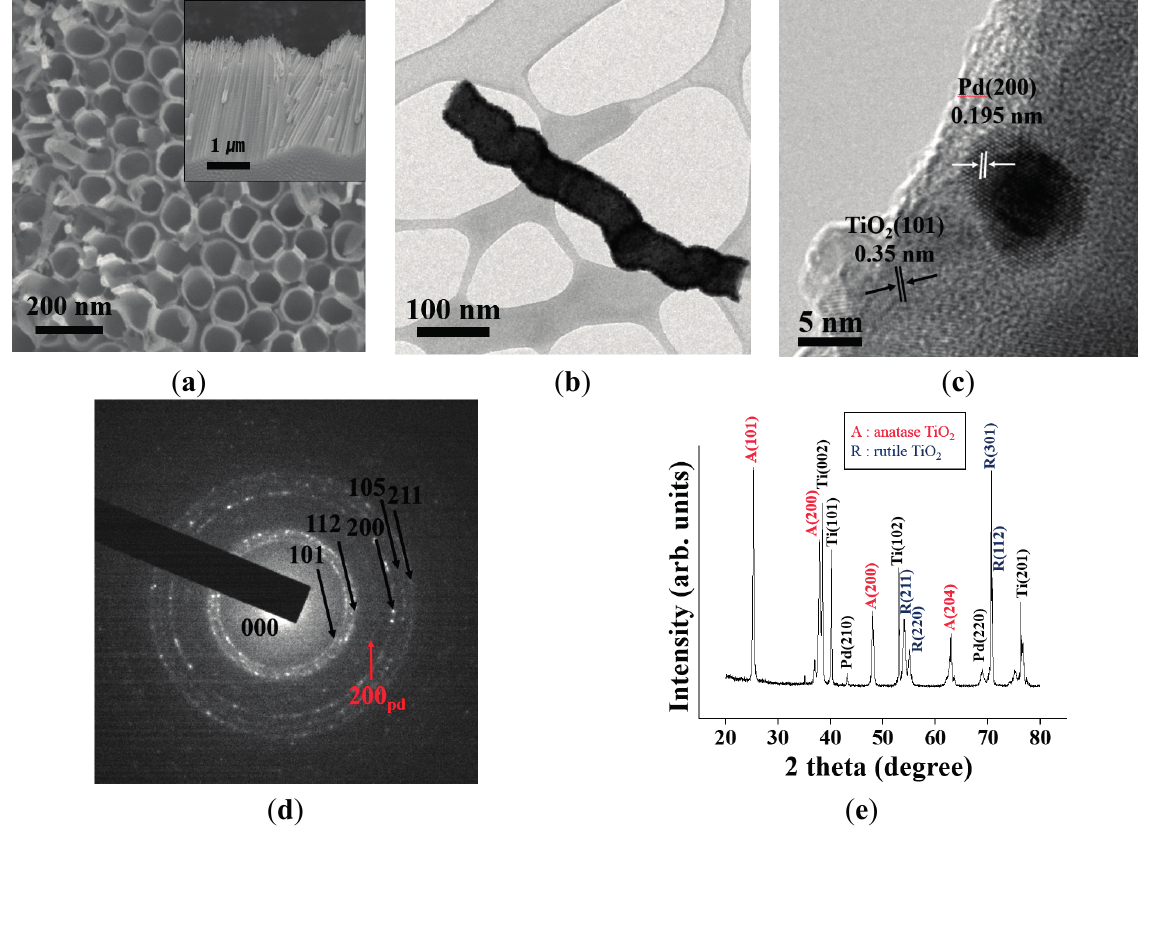
nanotubes; Figure 1. ( a ) Scanning electron microscopy image of Pd-functionalized TiO 2 ( b ) Low-magnification transmission electron microscopy (TEM) image of a typical Pd-functionalized TiO nanotube; ( c ) High-resolution TEM image and ( d ) Corresponding 2 nanotube; selected area electron diffraction pattern of a typical Pd-functionalized TiO 2 ( e ) X-ray diffraction pattern of Pd-functionalized TiO 2